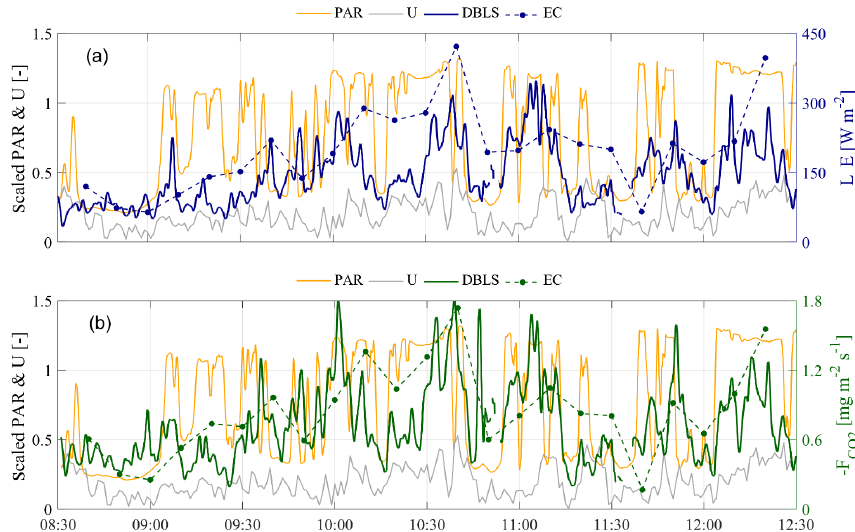
Figure 12. IOP 2 (15 June 2018) time-series of (a) latent heat fluxes (LvE) at 1min intervals with a displaced-beam laser scintillometer (DBLS) and at 10min intervals with an eddy covariance system (EC) combined with scaled time series of photosynthetically active radiation (PAR, scaled by 1500µmolm − 2 s − 1 ) and wind speed ( U , scaled by 6ms − 1 ). Panel (b) is the same as (a) but for the CO 2 flux ( F CO